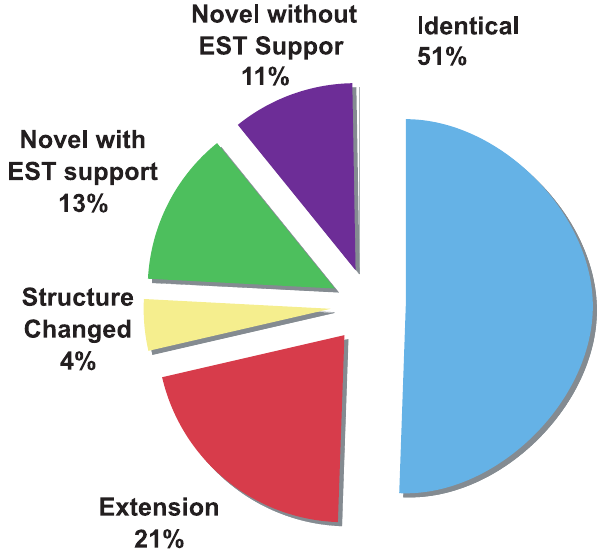
Figure 2. Comparison between the newly annotated CDS and AgamP3.4 CDS. We expanded the Anopheles gambiae annotation by increasing the completion rate through extension of genes and discovered more than 2,000 EST-supported novel genes without over- prediction.